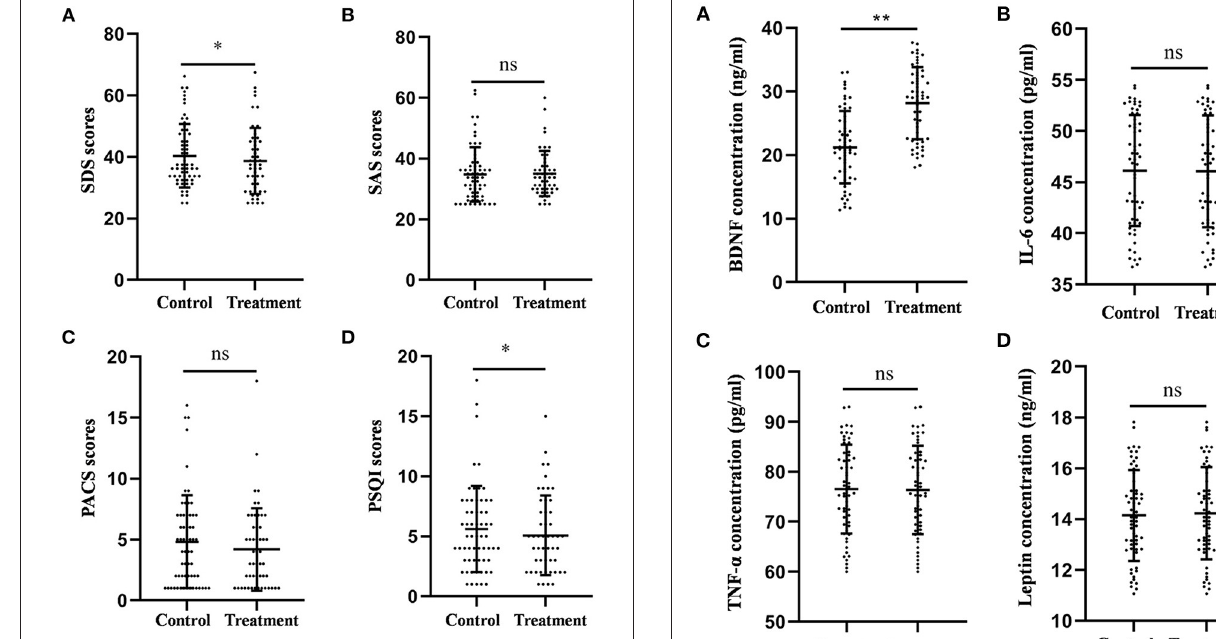
FIGURE 1 | Comparison of the scores of the SDS (A) , SAS (B) , PACS (C) , and PSQI (D) between the treatment group and the control group after 4-week treatment. * P < 0.05, was considered statistically significant.